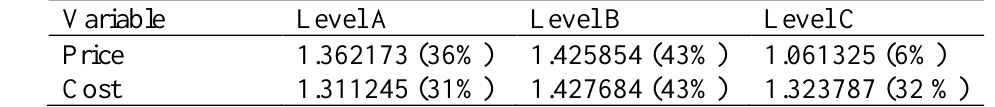
Fig. A1. Profits for mid and end of the 21 st century under different future scenarios of price and cost. Each level represents the original value x random multiplayer (see Table A1). Category “Original” represents the values used in the present study. Table A1. Values randomly selected for each future scenario used in the sensitivity